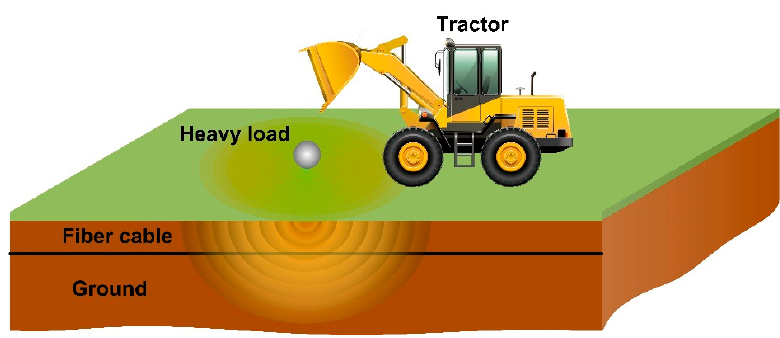
Figure 3. Registration of waves excited when a heavy load falls to the ground.